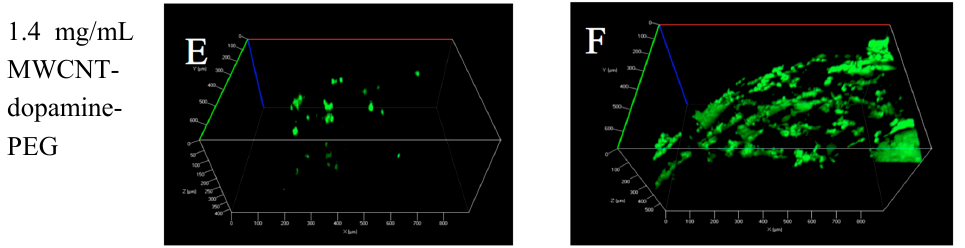
Figure 4. Live/dead test of bone marrow stromal cells (BMSCs) cultured on dopamine-PEG hydrogel on ( A ) day 1 and ( B ) day 5; on 0.7 mg/mL MWCNT-dopamine-PEG hydrogel ( C ) day 1 and ( D ) day